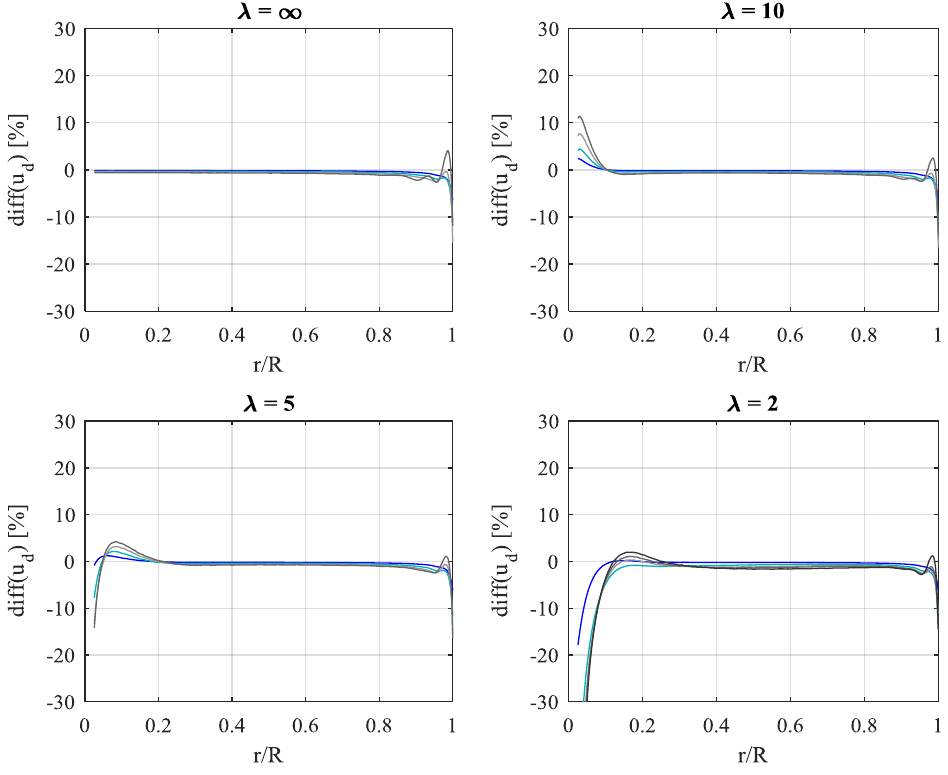
Figure 10. BEM-E-S12 results compared to AD.